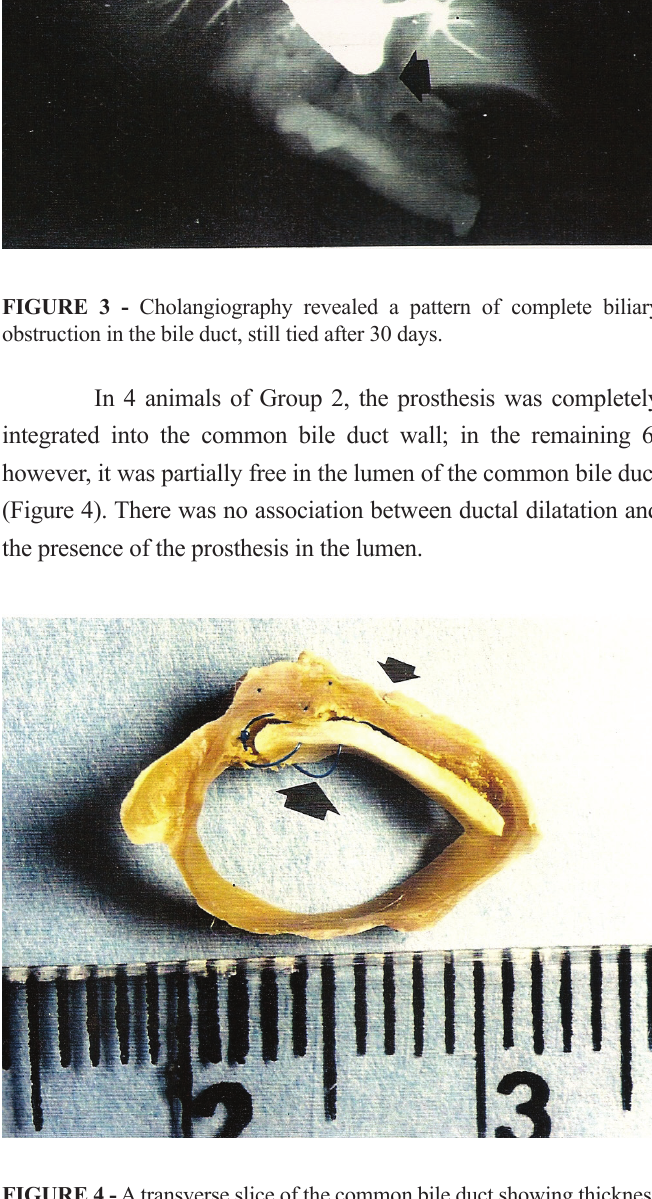
FIGURE 4 - A transverse slice of the common bile duct showing thickness (small arrow) and the prosthesis still tied at one of its ends by the prolene suture (large